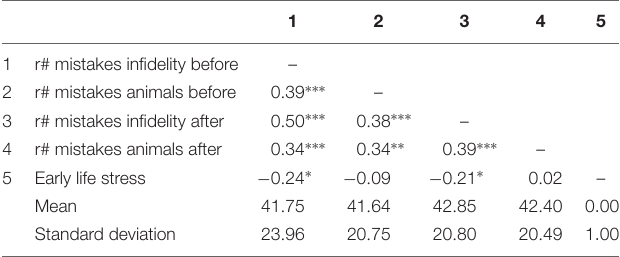
TABLE 4 | Pattern of associations between main study measures as well as means and standard deviations (Study 2).